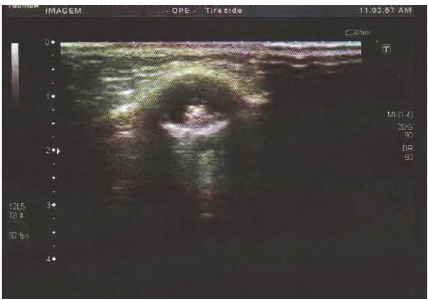
Figure 1: Sonography shows an image suggestive of thyroglossal duct cyst containing debris and an eccentric small hyperechoic solid